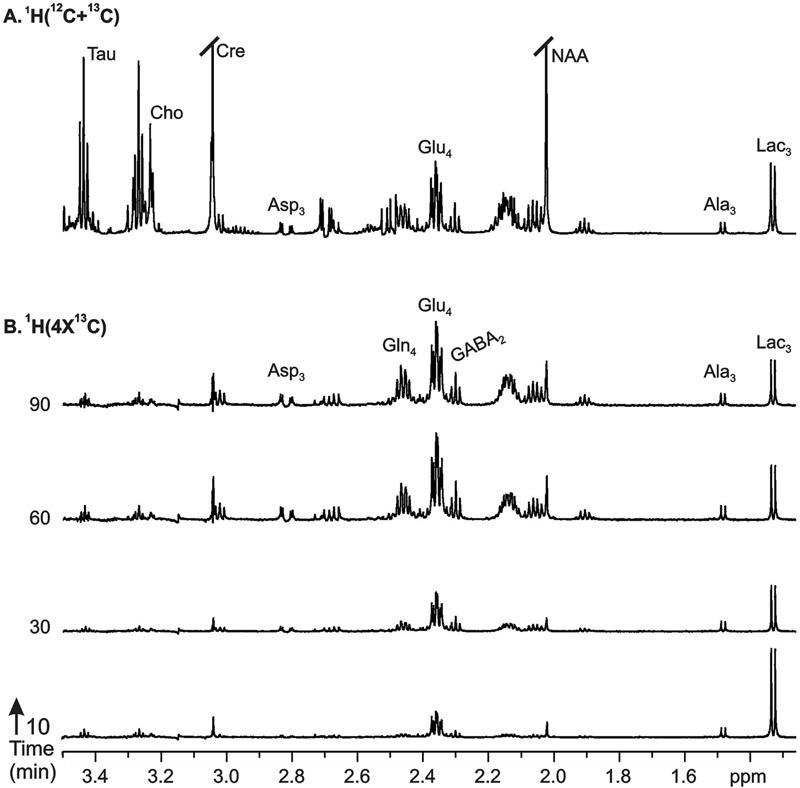
Representative 1H-[13C]-NMR spectra from cortical tissue extracts of AlCl3 treated mice: (A)1H-[12C+13C] represents total concentration of metabolites, (B)1H-[4x13C] depicts 13C labeling of metabolites from [1,6-13C2]glucose. Mice were infused with [1,6-13C2]glucose for pre-defined time, and 1H-[13C]-NMR spectra were recorded from cortical tissue extracts. Peak labels are: AlaC3, alanine-C3; AspC3, asparate-C3; GABAC2, GABA-C2; GlnC4, glutamine-C4; GluC4, glutamate-C4.